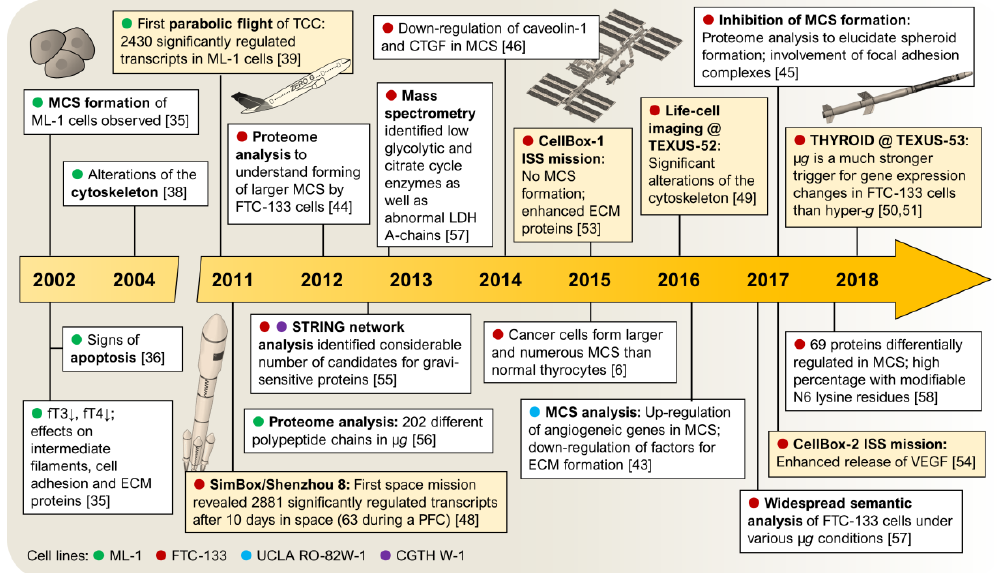
Figure 1. Timeline: research on thyroid cancer in microgravity. White squares: studies in simulated µ g ; yellow squares: studies in real µ g . PFC: parabolic flight campaign, TCC: thyroid cancer cells.